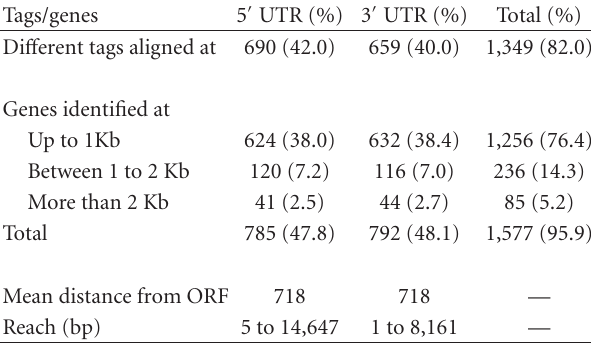
Table 3: Results of conventional BLAST alignments of 1,645 tags with two or more copies in the L. i. chagasi library per alignment region and distance from the nearest